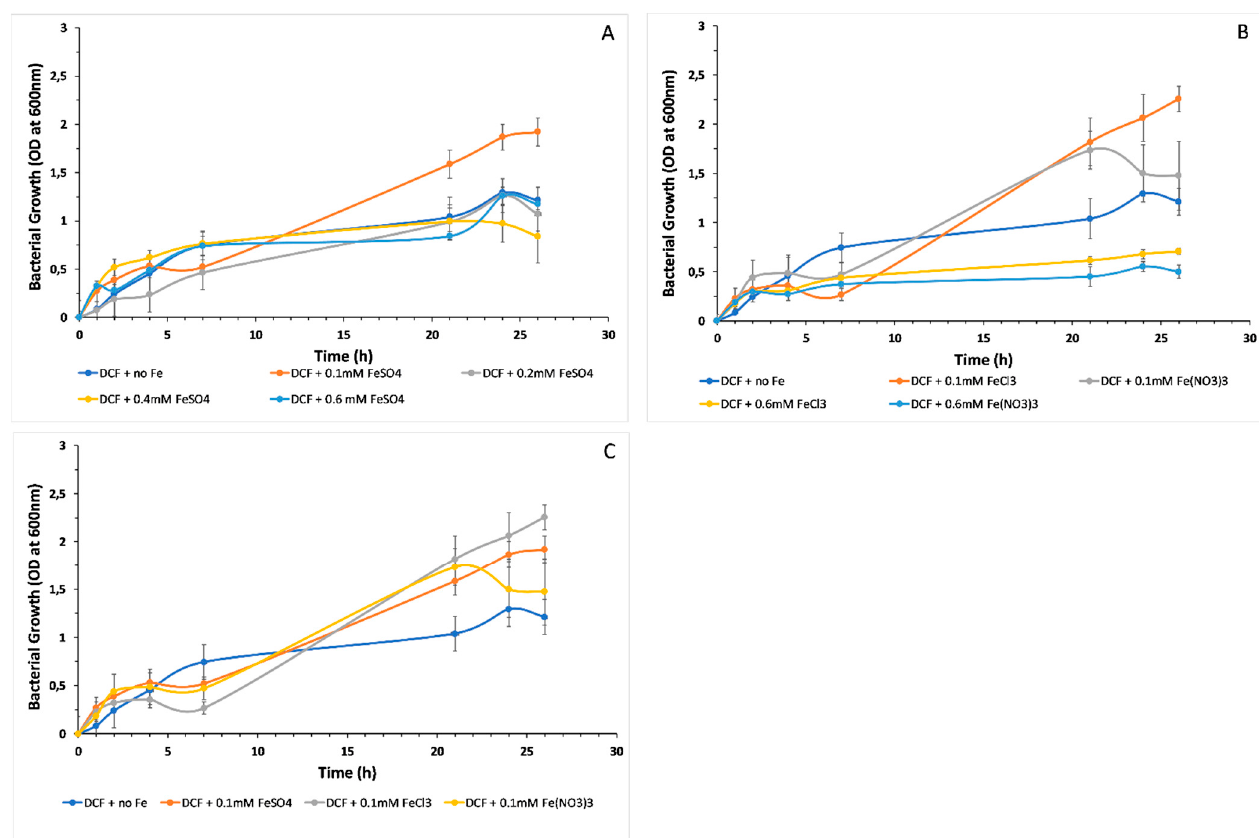
Figure 1. Microbial net growth of P. citronellolis 620C with 1% ( v / v ) drill cutting fluid (DCF) as substrate: ( A ) with and without the supplementation of different concentration levels of FeSO 4 , ( B ) with and without the addition of high and low concentration level of FeCl 3 and Fe(NO 3 ) 3 , ( C ) comparison when different 0.1 mM iron forms are supplemented.